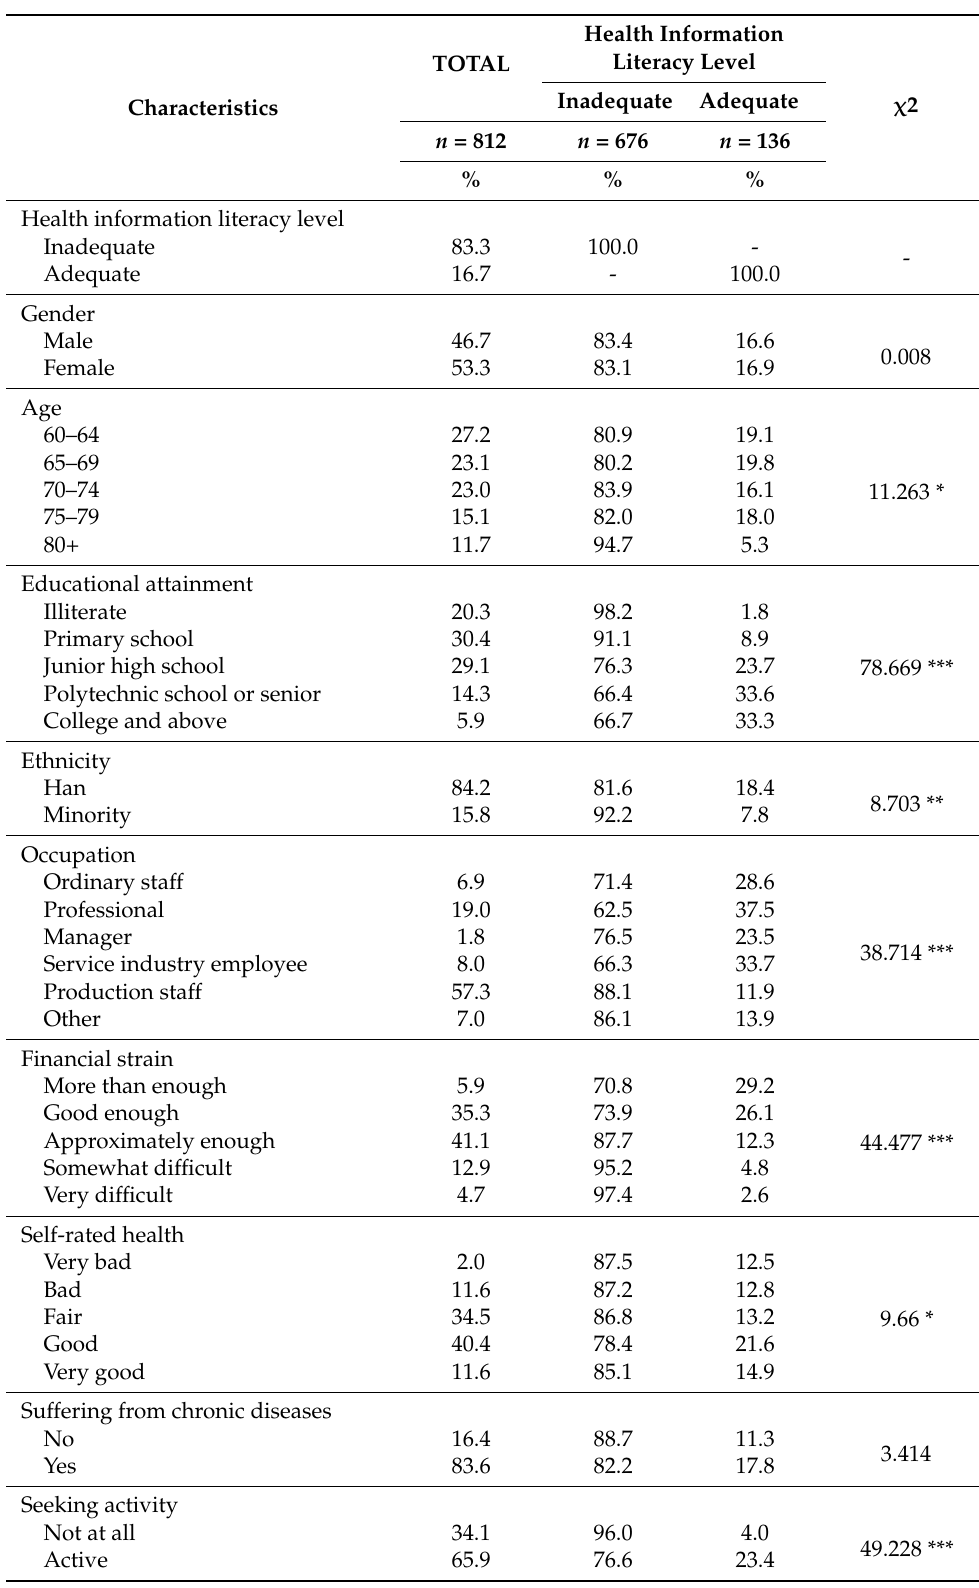
Table 1. Characteristics of the sample by health information literacy